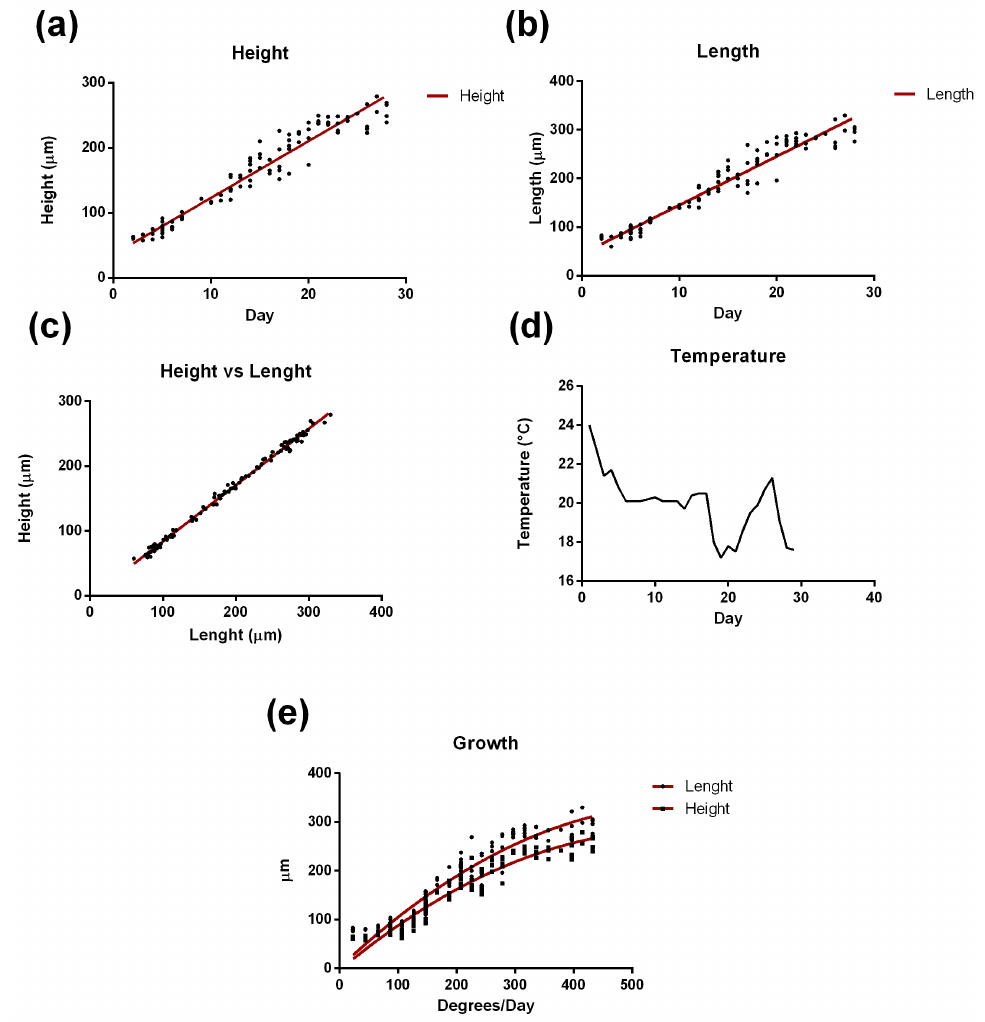
Figure 2. Larval growth data of the species Mesodesma mactroides: regressions for growth data as a function of time in degrees* day. (a) Height = 31.05 ± 0.92; Day + 12.07 ± 15.51; r 2 = 0.91; p < 0.0001. (b) Length = 35.78 ± 1.1; Day + 16.66 ± 18.0; r 2 = 0.91; p < 0.0001. (c) Height = 0.86 ± 0.005 Length = 1.298 ± 2.96; r 2 = 0.99; p < 0.0001. (d) Average temperatures in the experimental period. (e) Length = 2.5 ± 0.11 degrees* day + 33.88 ± 24.66; r 2 = 0.91; p < 0.0001, Height = 2.17 ± 0.09 degrees* day + 27.09 ± 21.33; r 2 = 0.91; p <